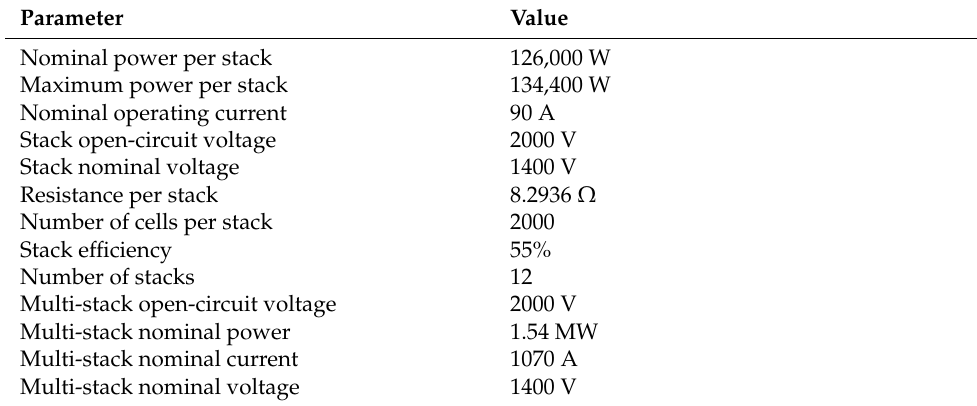
Table 2. Proton Exchange Membrane Fuel Cell (PEMFC) multi-stack parameters